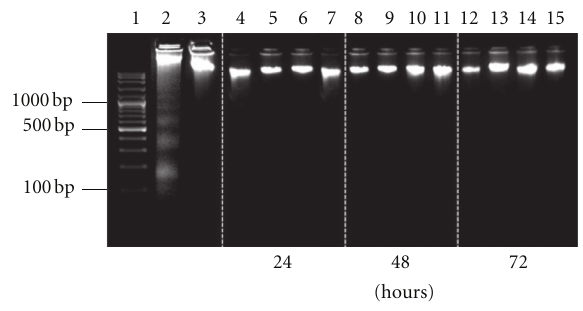
Figure 3: DNA laddering assay showing no DNA fragmentation or necrosis in MCF-7 cells treated with EOace and EOea at various time intervals., Lanes 1: DNA 100 bp ladder; 2: positive control; 3: negative control (untreated cells); 4 and 5: EOea-treated